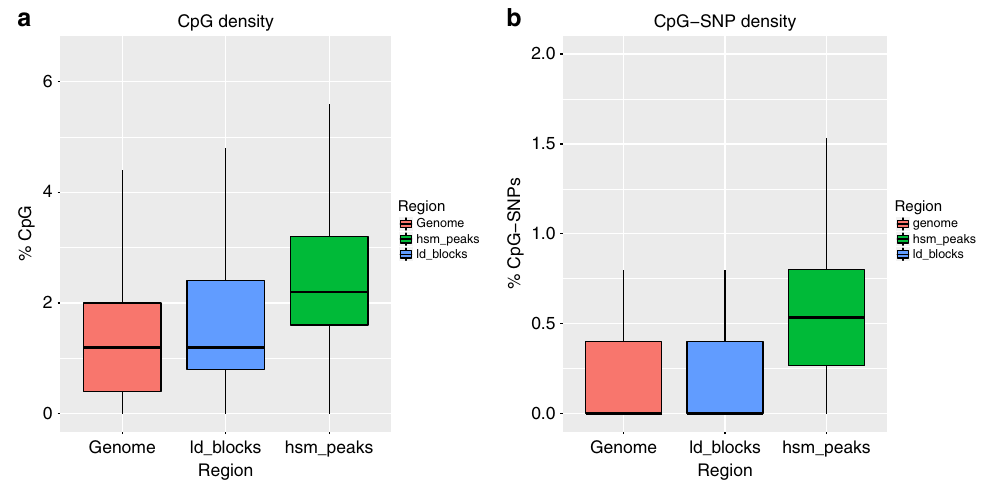
Fig. 5 CpG and CpG-SNP density within HSM peaks. a CpG density and b CpG-SNP density within HSM peak regions compared to within GWAS LD block regions and genome. (Expressed as % of sequence, i.e. 50 CpGs in 100 bp =